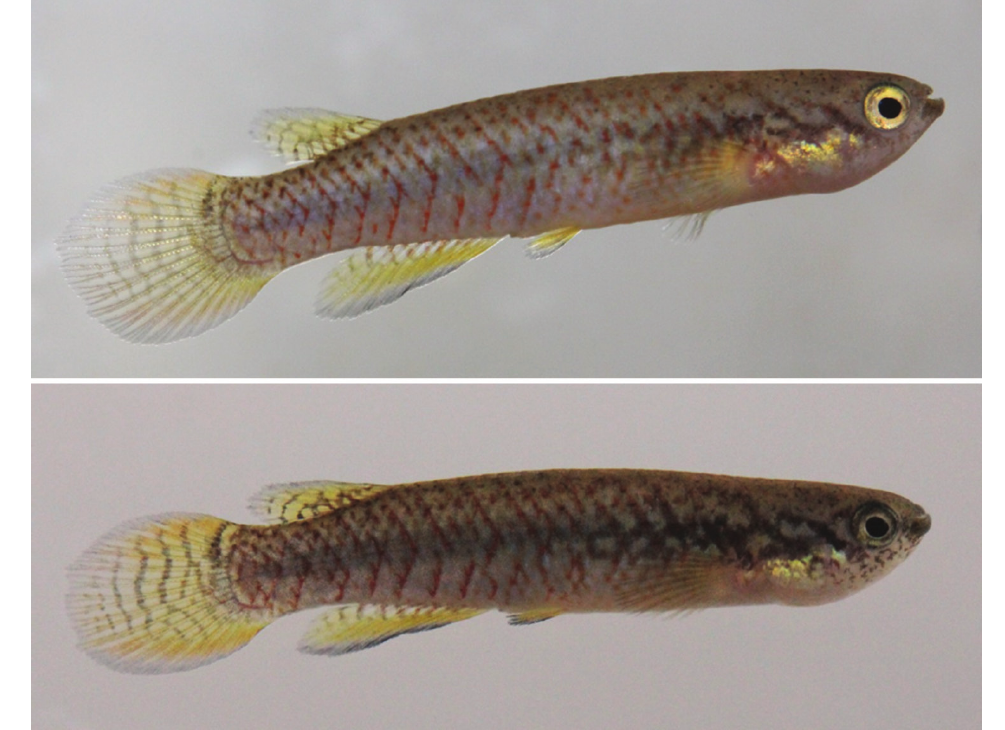
Figure 9. Colour pattern variation of females of M. amambaiensis (not preserved), sp. n., small stream tributary of Rio Amambaí, Mato Grosso do Sul